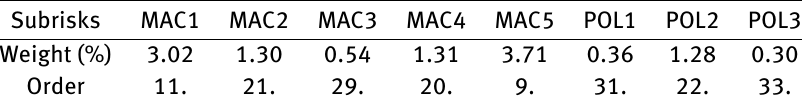
Table 5: Resulting values of subrisks weights – Part III.